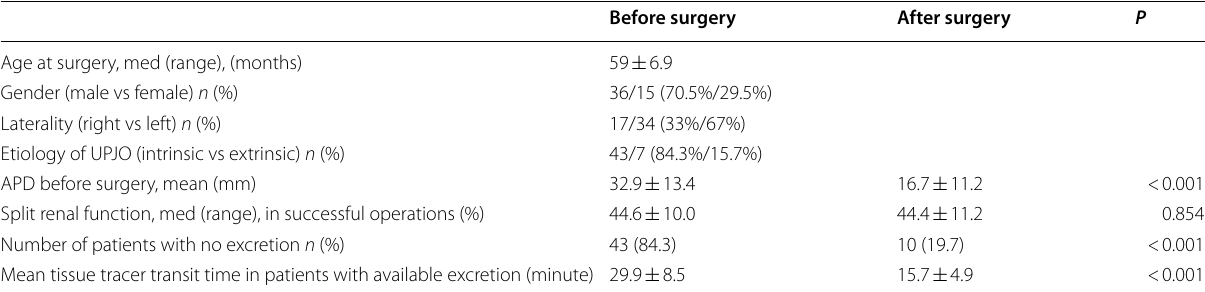
Table 1 Preoperative and postoperative demographic properties and radiological findings Age at surgery, med (range), (months) 59